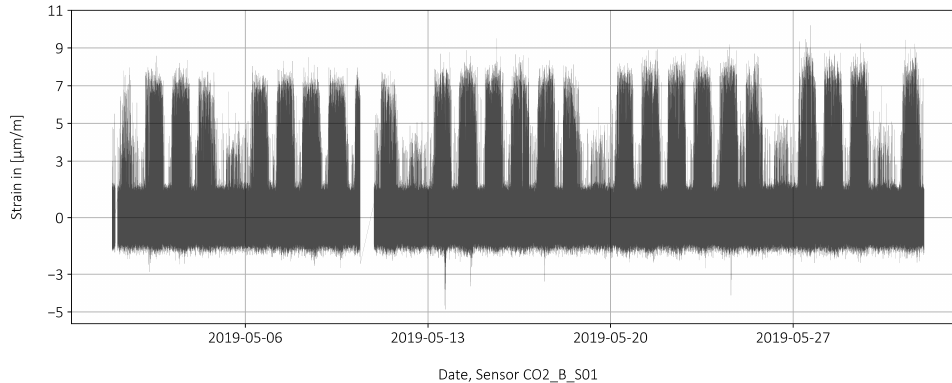
Figure 7. The normalized strain after applying a moving average smoothing.